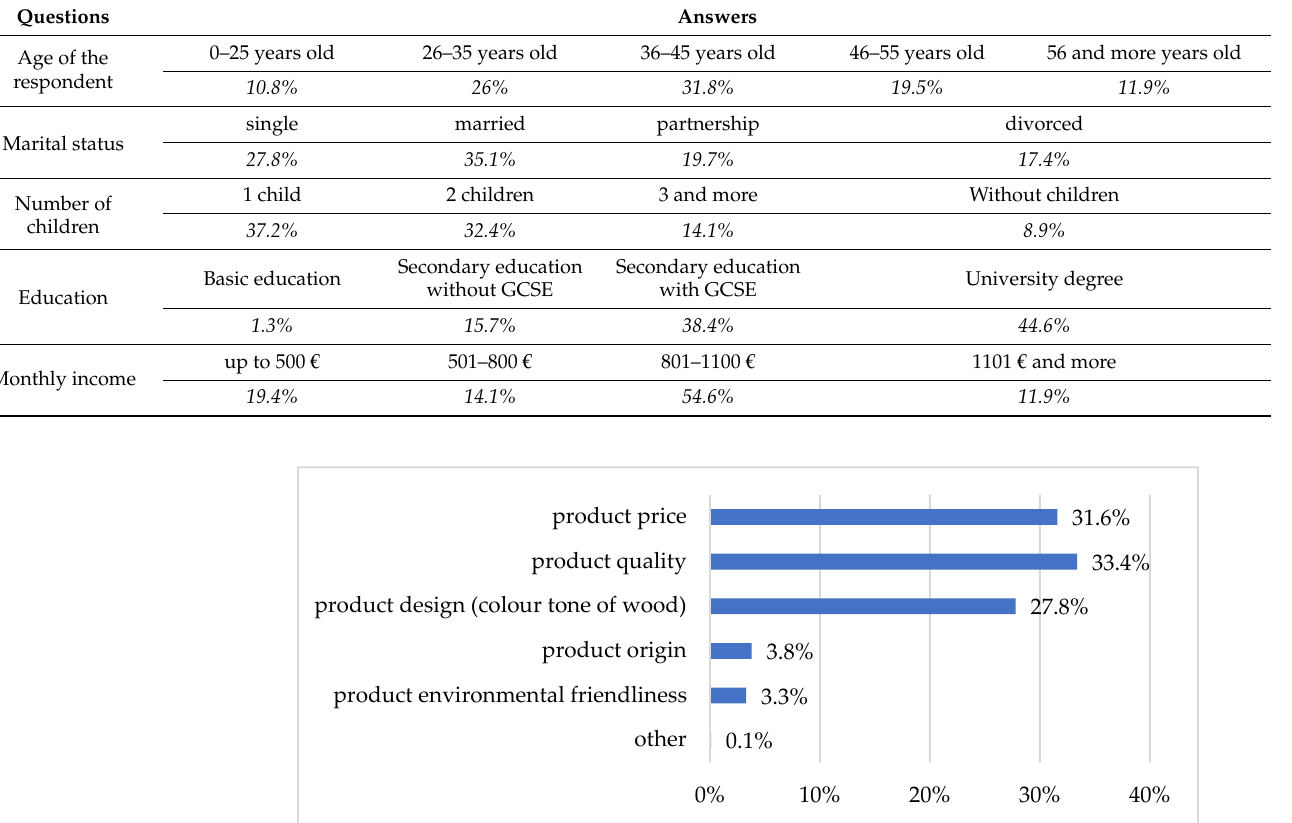
Figure 4. Key criteria of consumers when buying wood products.